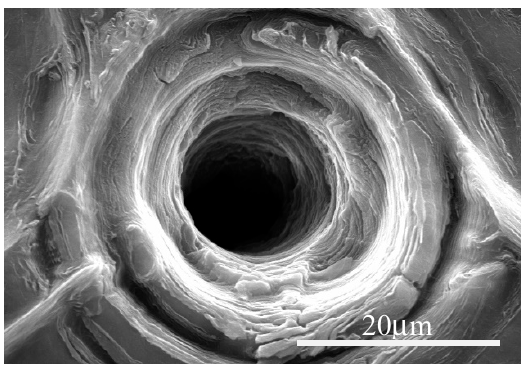
Figure 10. The result of graphene paper microdrilling with the use of a picosecond laser.